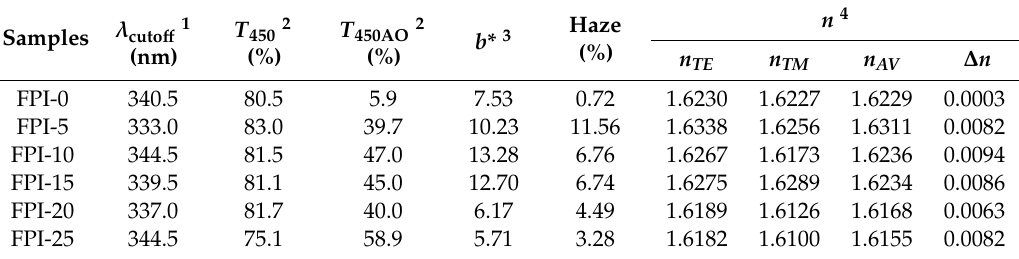
Table 2. Optical properties of FPI / TSP composite